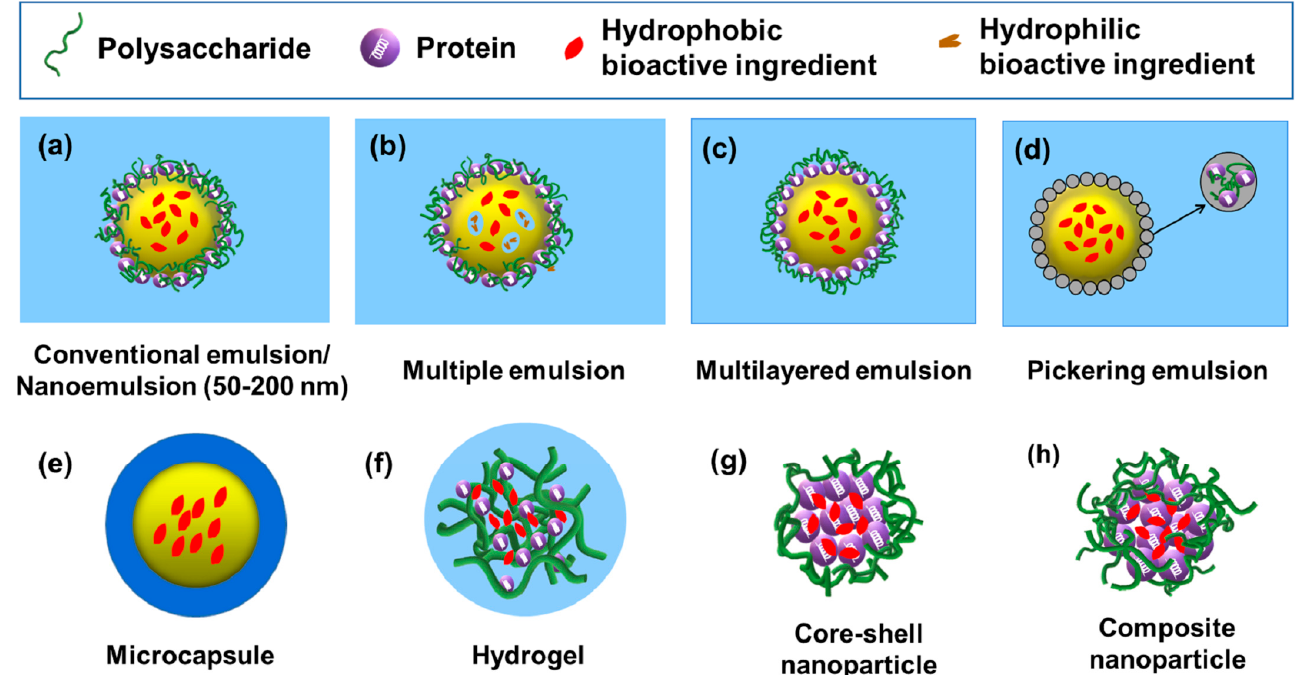
Figure 2. Different types of protein–polysaccharide complex/conjugate-based delivery systems for bioactive ingredients. ( a ) Conventional emulsion/Nanoemulsion (50–200 nm); ( b ) Multiple emulsion; ( c ) Multilayered emulsion; ( d ) Pickering emulsion; ( e ) Microcapsule; ( f ) Hydrogel; ( g ) Core-shell nanoparticle; ( h ) Composite nanoparticle.